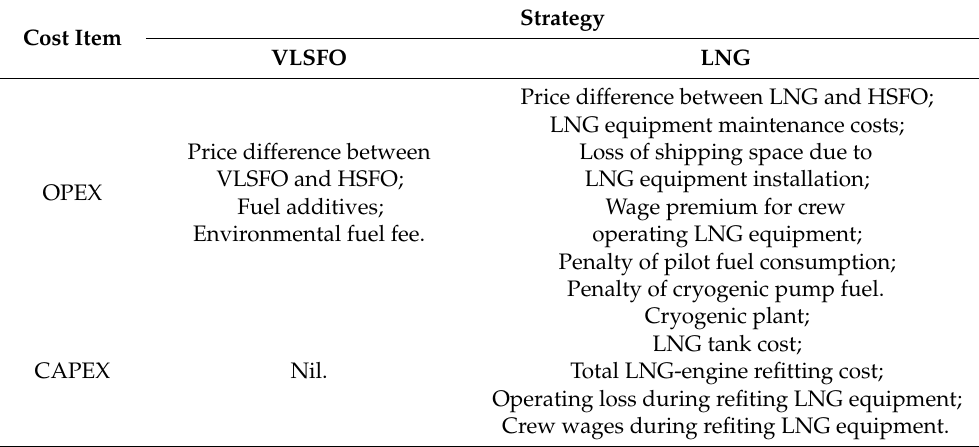
Table 7. Cost items of strategies VLSFO and